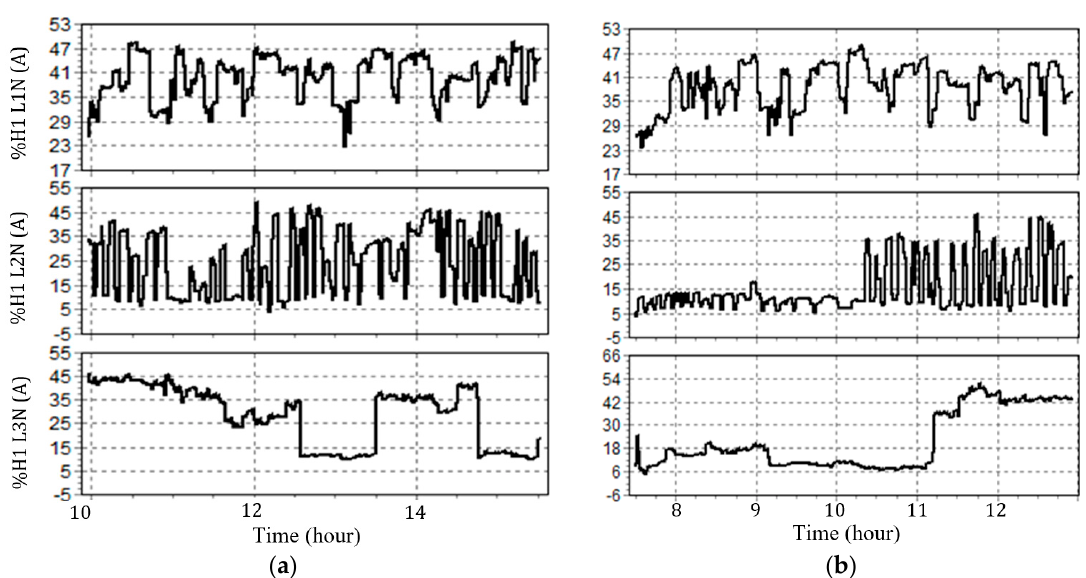
Figure 4. Total current THD for each phase: ( a ) during the first period (9 January 2020); ( b ) during the second period (10 January 2020).